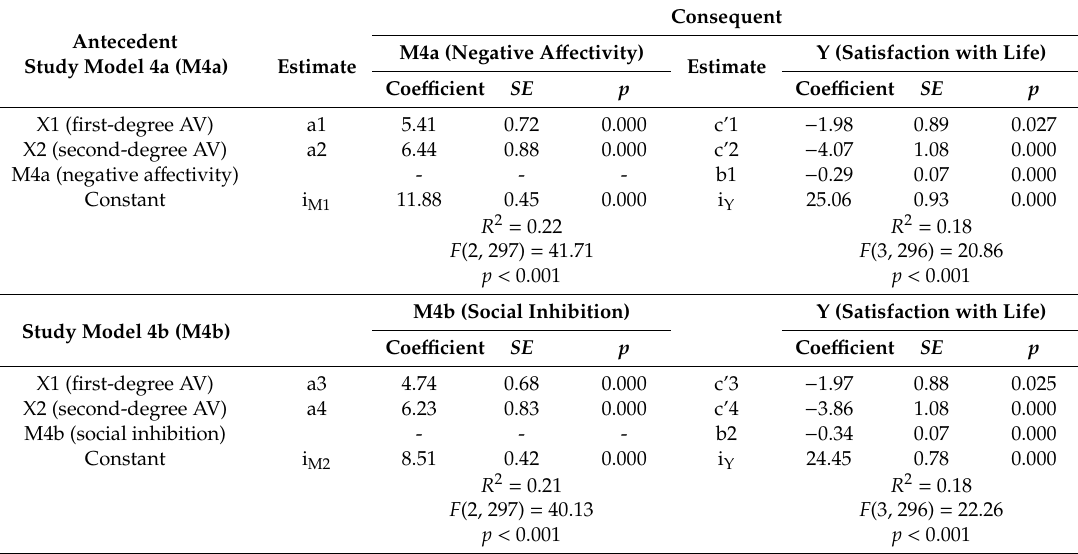
Figure 2. Parallel multiple mediation model for predicting satisfaction with life (Study Model 4). Table 6. Path coefficients of acne severity (X1, X2), negative affectivity (M4a), and social inhibition (M4b) on satisfaction with life (Y) in a parallel multiple mediation model.